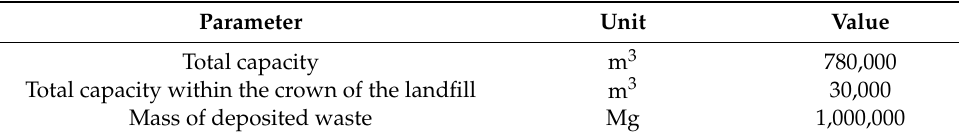
Table 1. Parameters of the test stand in Ga´c.